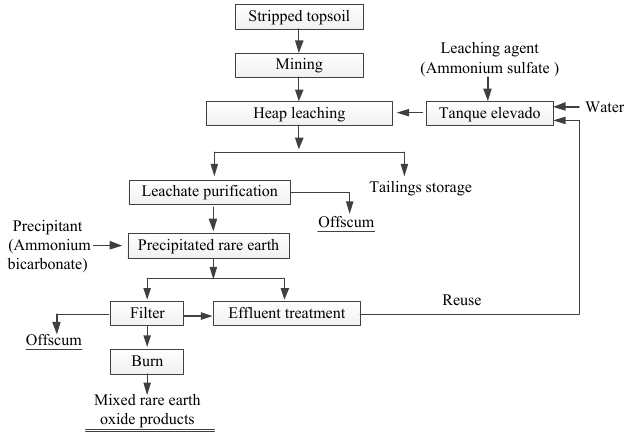
Figure 6. Second generation leaching extraction process.